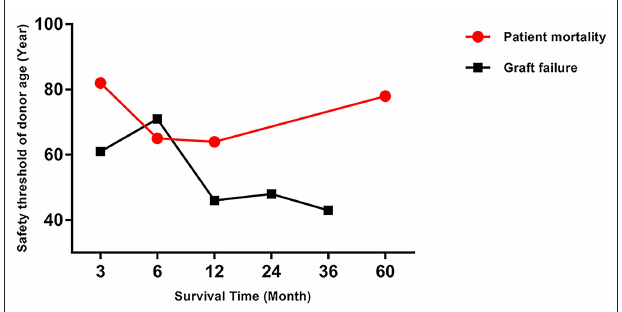
FIGURE 7 | Safety threshold of donor age on patient death and GF at different time-points. GF, graft failure.